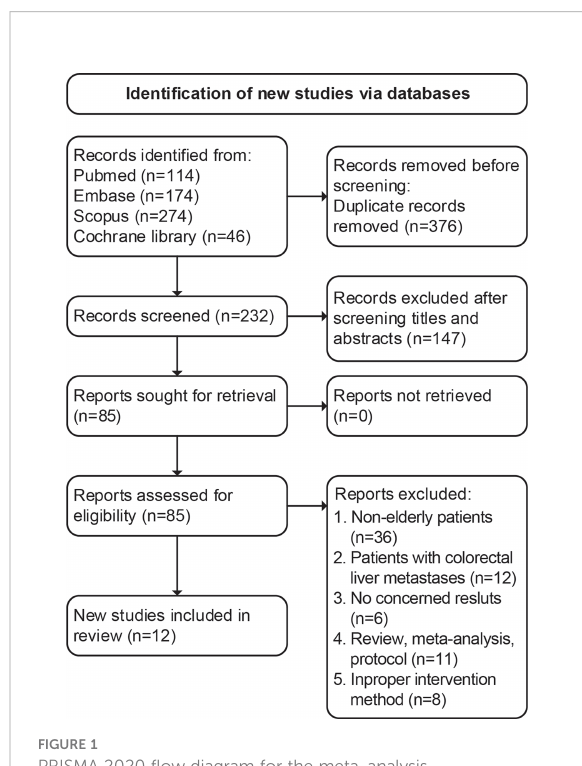
FIGURE 1 PRISMA 2020 fl ow diagram for the meta-analysis.